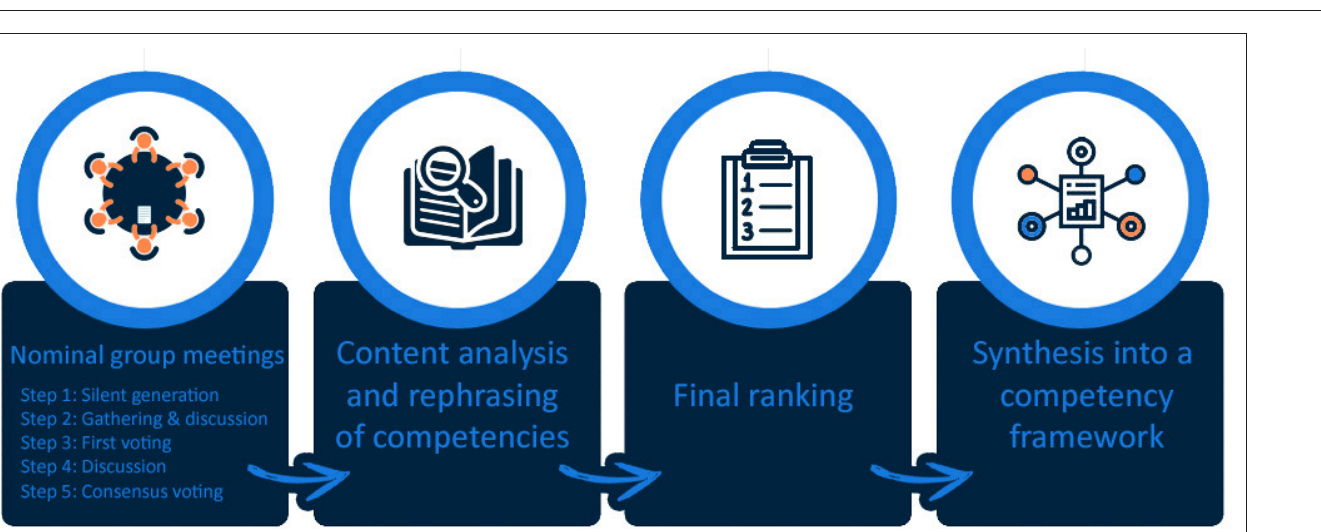
Figure 1 Schematic overview of the study